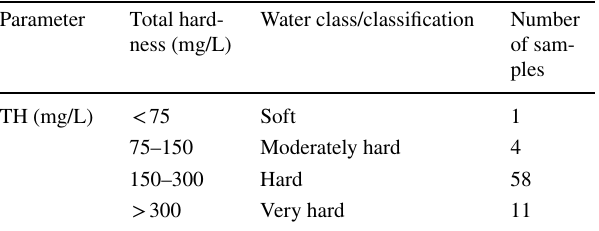
Table 3 Total hardness value of the samples (Sawyer and McCarthy